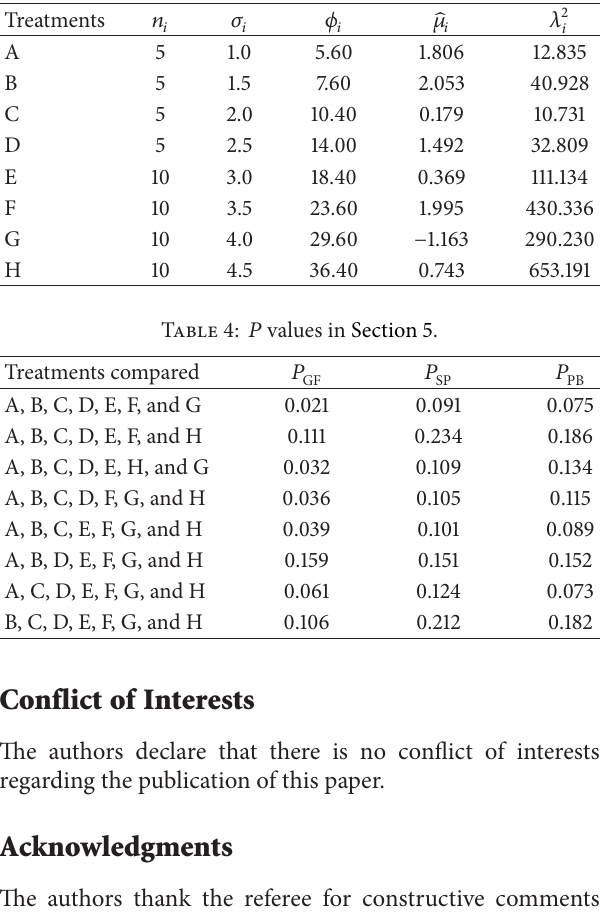
Table 3: Summary statistics in Section 5.